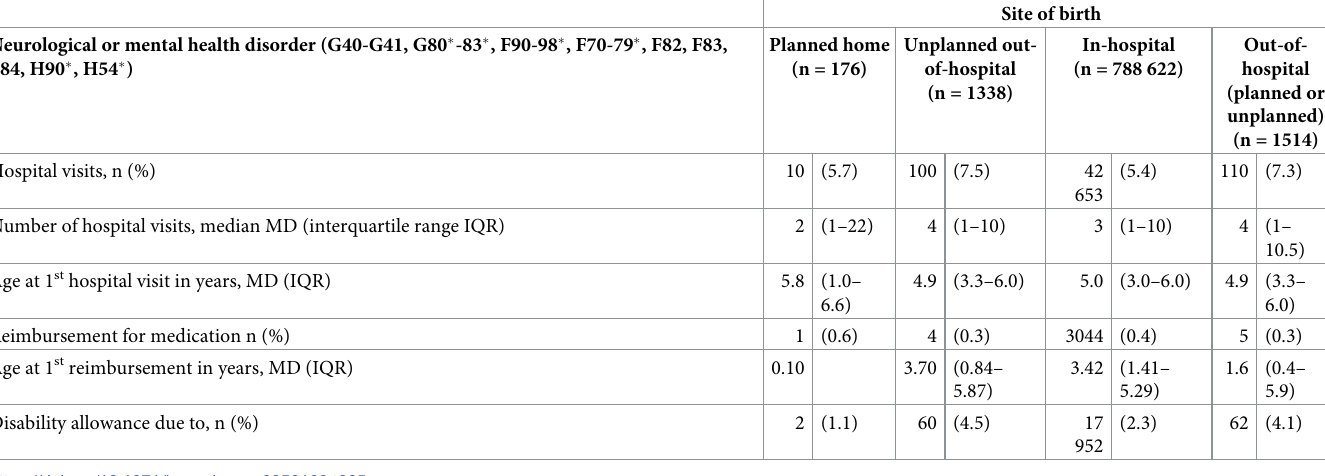
Table 5. Morbidity related to neurological or mental health disorders (n = 790